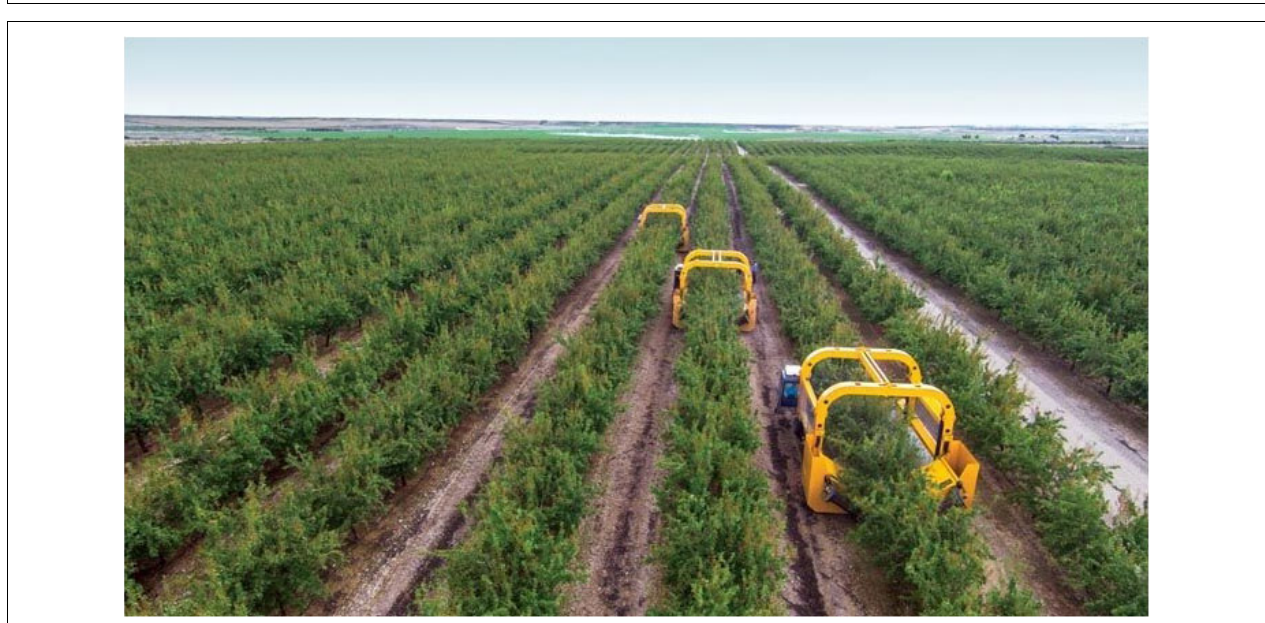
FIGURE 4 | Catch-frame harvesting of almonds in Spain using specialized equipment integrating tree-shakers and collection frames for catching harvested fruit (hulls plus nuts) before they hit the ground.